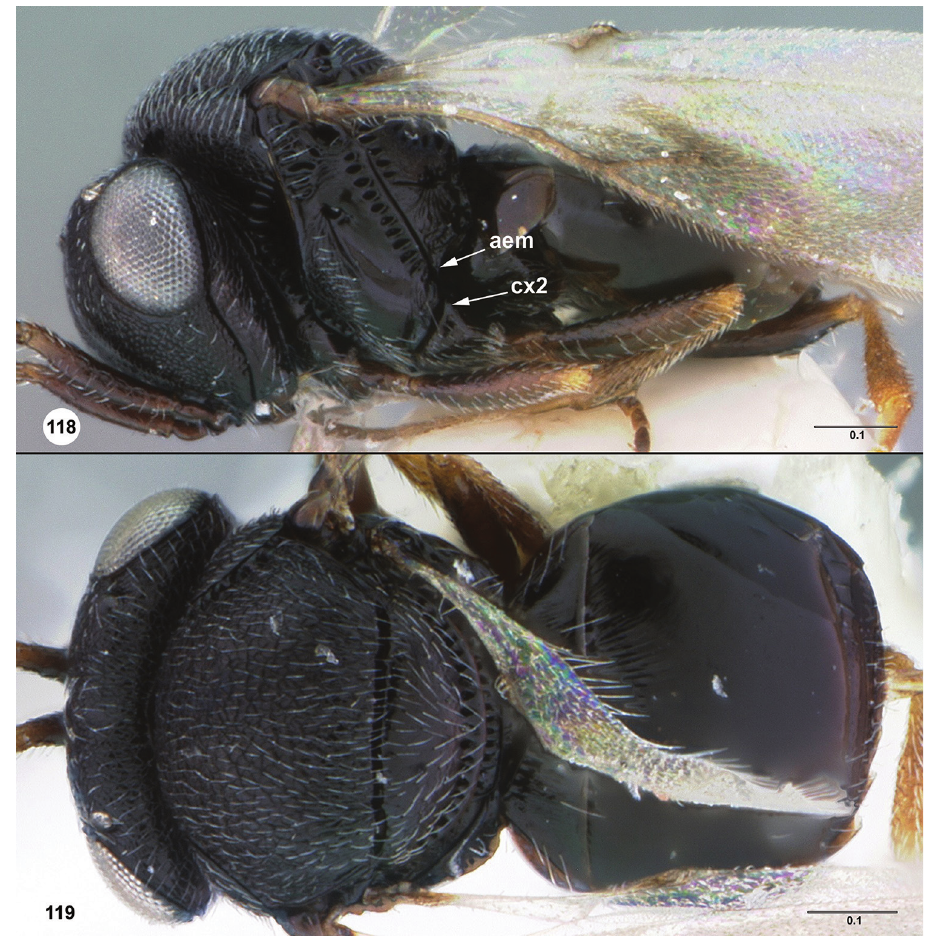
Figures 118–119. T. oobius , female paratype (USNMENT00916617) 118 head, mesosoma, metasoma, lateral view 119 head, mesosoma, metasoma, dorsal view. Scale bars in millimeters. Pattern of mesoscutal microsculpture: uniform throughout. Mesoscutal suprahumeral sulcus: comprised of cells. Length of mesoscutal suprahumeral sulcus: about half the length of anterolateral edge of mesoscutum. Parapsidal line: absent. Notaulus: absent; indicated only at posterior margin of mesoscutum. Median protuberance on anterior margin of mesoscutellum: absent. Protruberance on anterior margin of mesoscutel- lum directly posterior to notaulus: absent. Shape of dorsal margin of anterior lobe of axillar crescent: flat, appearing fused with lateral margin of mesoscutum. Sculpture of anterior lobe of axillar crescent: dorsoventrally strigose. Posterodorsal margin of axillular carina: round. Area bounded by axillar crescent: smooth. Macrosculpture of mesoscutellum: absent. Microsculpture on mesoscutellum: present throughout; absent; present laterally, absent medially. Median mesoscutellar carina: absent.